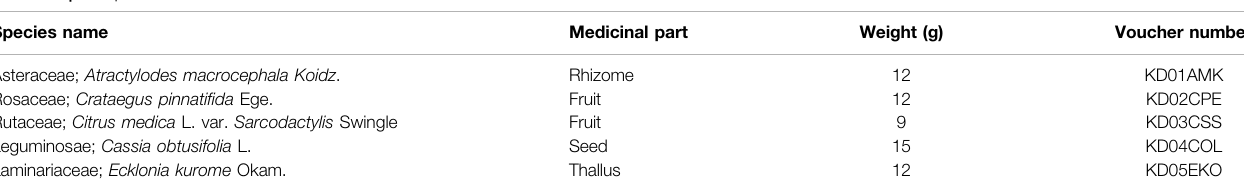
TABLE 1 | Components of